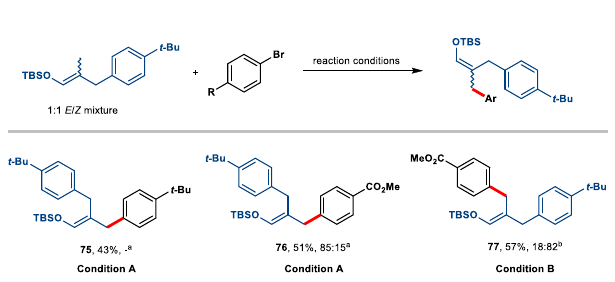
Fig. 9 | Electronic effect in the sequential diarylation coupling. a Condition A : the reactions were performed on a 0.2mmol scale under the following reaction conditions: alkene (3 equiv.), aryl bromide (1 equiv.), 2,6-lutidine (1.5 equiv.), PC-1 (1mol%), NiBr 2 (10mol%), dtbbpy (15mol%), benzene (2mL), rt, 60h. b Condition B : the reaction was performed on a 0.2mmol scale under the following reaction conditions: alkene (3equiv.),arylbromide(1equiv.),2,4,6-collidine (3equiv.), PC-1 (1mol%), NiBr 2 (20mol%), 6,6 ’ -dmbpy (20mol%), dioxane (2mL), rt, 60h. Yields and E / Z after puri fi cation by